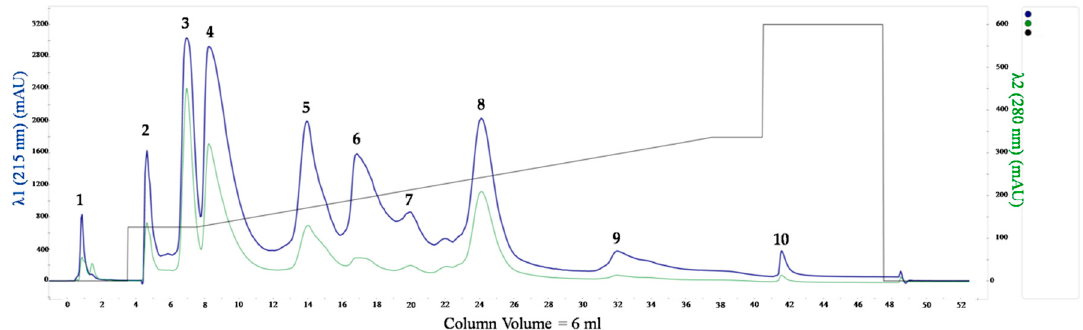
Figure 1. Representative chromatogram obtained for the separation of Naja ashei venom on the Resource S column. The fractions considered in the next stages of the experiment are marked by the numbers above the peaks.